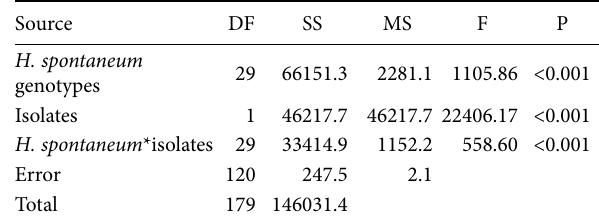
Table 1. Analysis of variance for the resistance of 30 Hordeum spon- taneum genotypes 45 d after planting following seed inoculation with two isolates of Drechslera graminea.